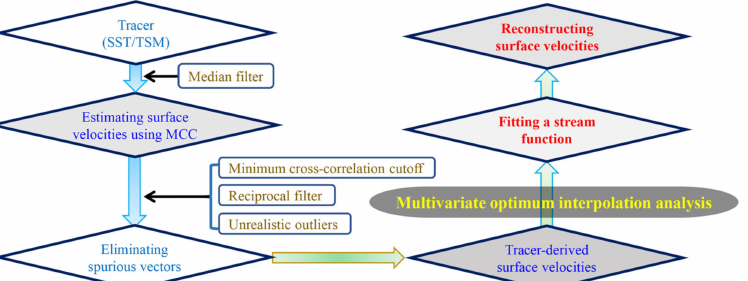
Figure 2. The schematic diagram for reconstructing surface velocity vectors. Concisely, initial surface velocity fields are estimated from tracers (SST and TSM) using the MCC method, and filtered by three statistical techniques to discard erroneous vectors. Multivariate optimum interpolation analysis is subsequently used to reconstruct surface velocity vectors by a fitted stream function based on the tracer-derived surface